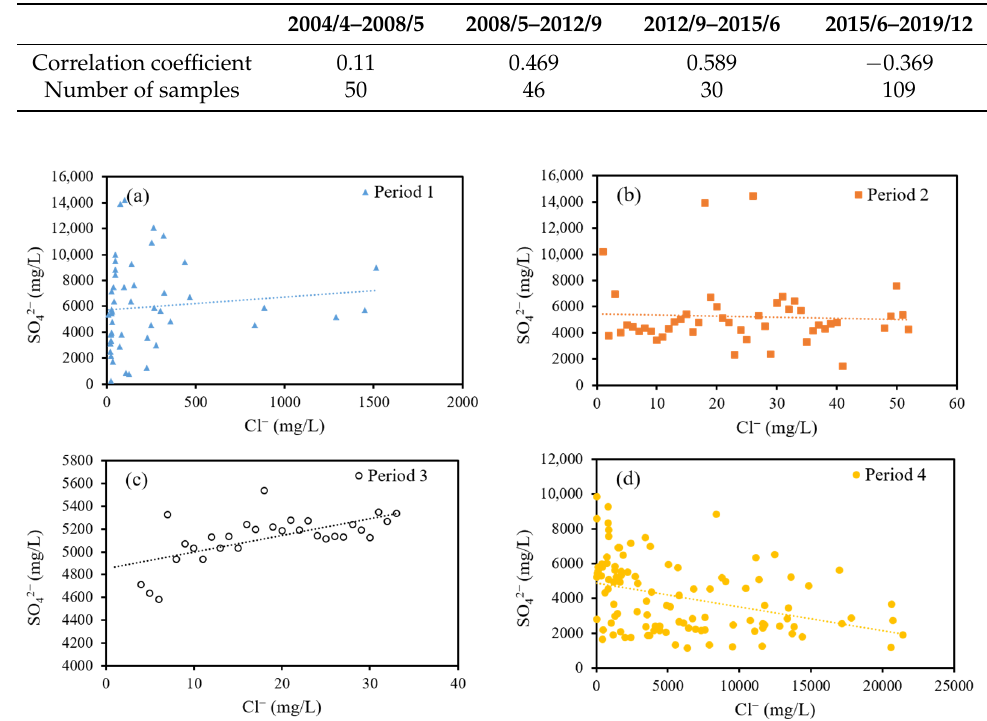
Table 1. Correlation coefficient between Cl − and SO 42 − of Tayukeng (TYK) thermal water in each period.